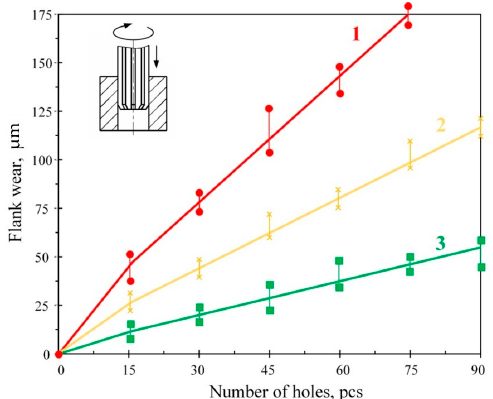
Figure 11. The dependence of wear on the back surface with different surface treatment on the number of machined holes in the blanks made of 41Cr4 steel: (1) uncoated; (2) TiN coated; (3) after combined surface strengthening.